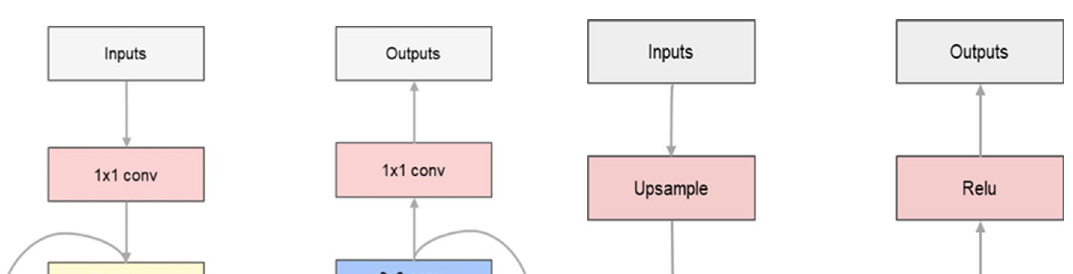
Figure 1. ADC_Net model structure.